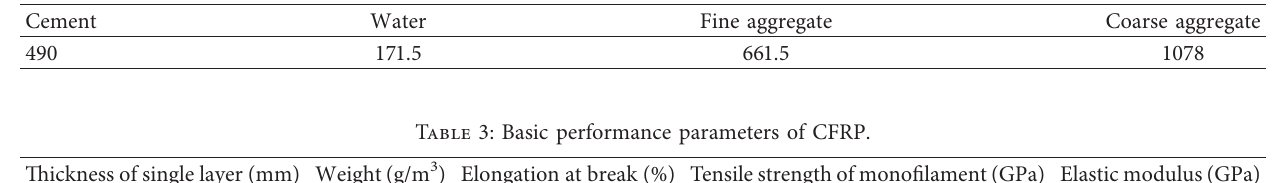
Table 2: Specific ratio of concrete kg/m 3